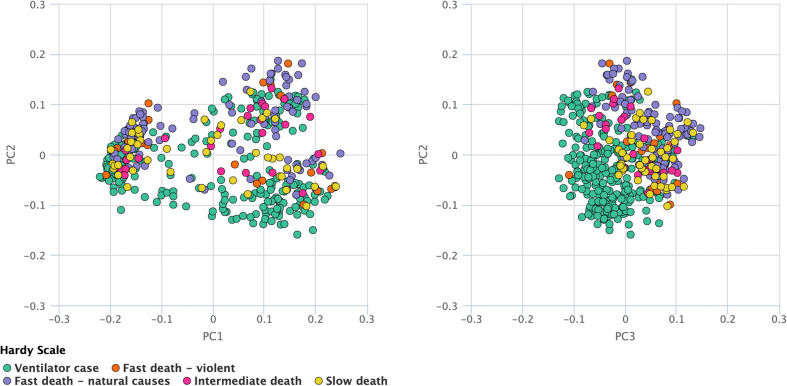
Principal component analysis. The TCGA and survival data is used for plotting the principal components. This analysis suggests that events which happened in the cell cycle control were likely to happen again in the TNBC as illustrated in Figure, where green dots depict the ventilator case, red dots depict fast death, violet dots show fast death (natural causes), pink dots represent intermediate death and yellow dots show slow deaths.